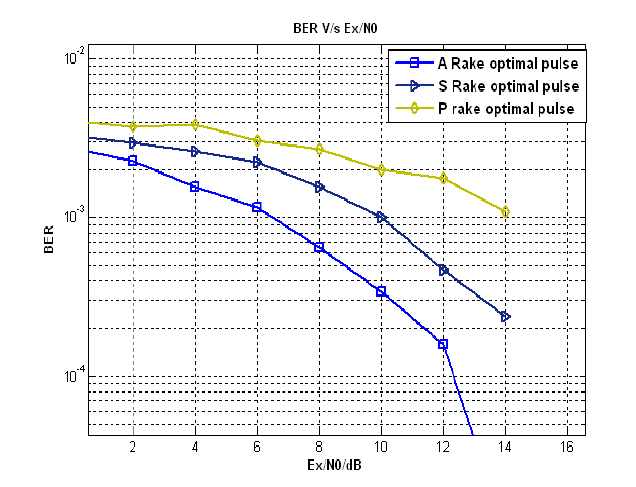
Fig.16. BER Analysis of System Model for the optimal pulse using optimal coefficients